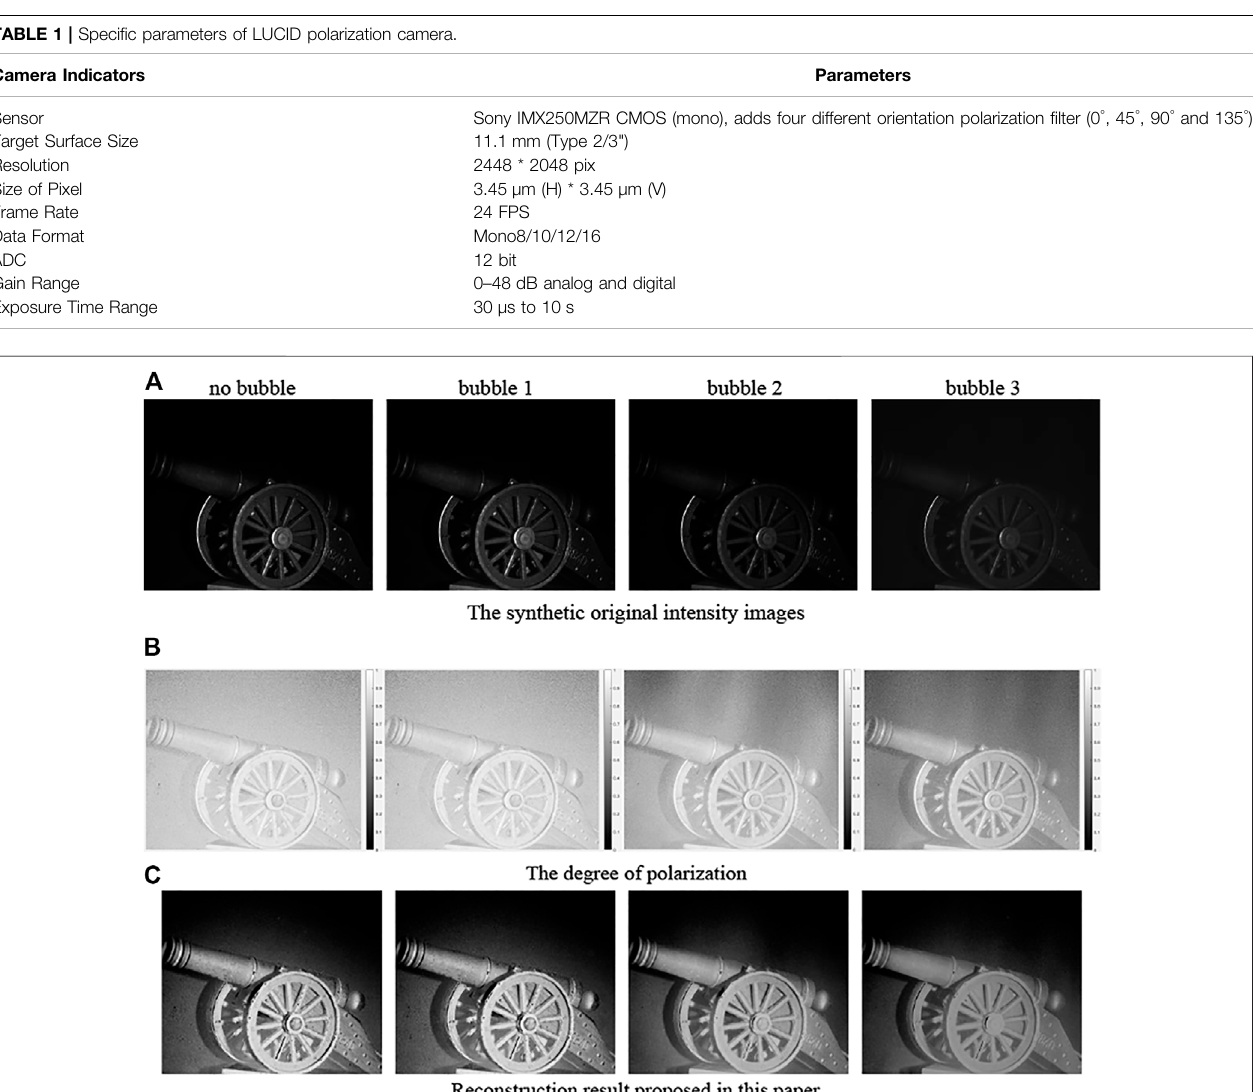
Frontiers in Physics |